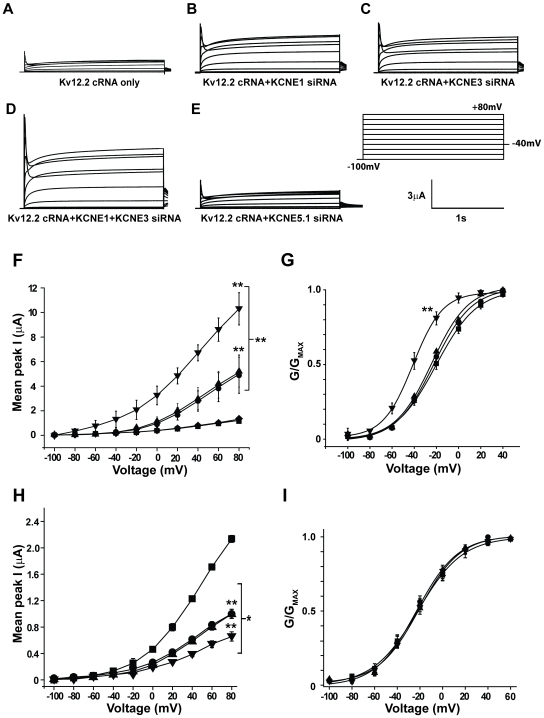
KCNE1 and KCNE3 inhibit Kv12.2 currents in Xenopus oocytes.(A–E) Current traces recorded from oocytes injected with (A) Kv12.2 cRNA only, or co-injected (B) KCNE1, (C) KCNE3, (D) KCNE1 and KCNE3, or (E) KCNE5.1 siRNAs. Currents were recorded in response to 2 s voltage steps from −100 to +80 mV, in 20 mV increments from a holding potential of −100 mV; tail currents were recorded at −40 mV (protocol in inset). (F) Peak current-voltage relationships from oocytes injected with Kv12.2 cRNA only (▪), or Kv12.2 cRNA plus either KCNE1 (•), KCNE3 (▴), KCNE1 and KCNE3 (▾), or KCNE5.1 (♦) siRNAs. KCNE1 and KCNE3 siRNAs significantly increase Kv12.2 currents and have an additive effect in combination. (Mean±SEM, n = 12–16, ** p<0.01). (G) Normalized conductance voltage (GV) curves measured from isochronal tail currents for oocytes injected with Kv12.2 cRNA only (▪), and either KCNE1 (•), KCNE3 (▴), or KCNE1+KCNE3 (▾) siRNA. Lines show Boltzmann fits; parameters are given in the Results. Only dual injection of xKCNE1 and xKCNE3 siRNAs caused a significant shift in V50. Data are given as Mean±SEM, n = 12–16, (** p<0.01). (H) Peak current-voltage relationships from oocytes injected with Kv12.2 cRNA (▪), or Kv12.2 cRNA+mKCNE1 (•), mKCNE3 (▴), mKCNE1 and mKCNE3 (▾) cRNA (protocol as in A, Mean±SEM, n = 8, * p<0.05, ** p<0.01). Co-injection of Kv12.2 with mKCNE1 and/or mKCNE3 cRNA significantly reduced Kv12.2 currents. (I) GV curves from isochronal tail currents recorded from oocytes injected with Kv12.2 cRNA (▪), or Kv12.2 and either mKCNE1 (•), mKCNE3 (▴), and mKCNE1 and mKCNE3 (▾) cRNA. Boltzmann fits (lines) revealed that the voltage-dependence of Kv12.2 activation was not significantly affected by overexpression of KCNE1 and KCNE3. V50 values are given in the Results (n = 8).